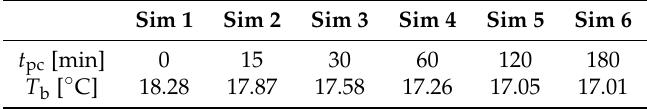
Table 5. Reached maximum temperatures for the pre-cooling